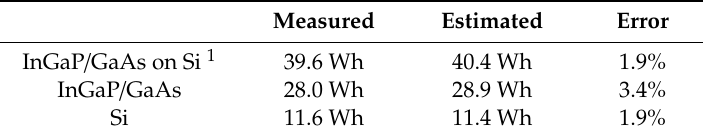
Figure 6. Validation of the performance model (MS2E model) to 4T tandem module, decomposing performance in each output terminal (InGaP/GaAs top cell and Si bottom cell). Table 2. Comparison between measured and estimated (predicted by MS2E model) energy yield in a day (3 January 2019).